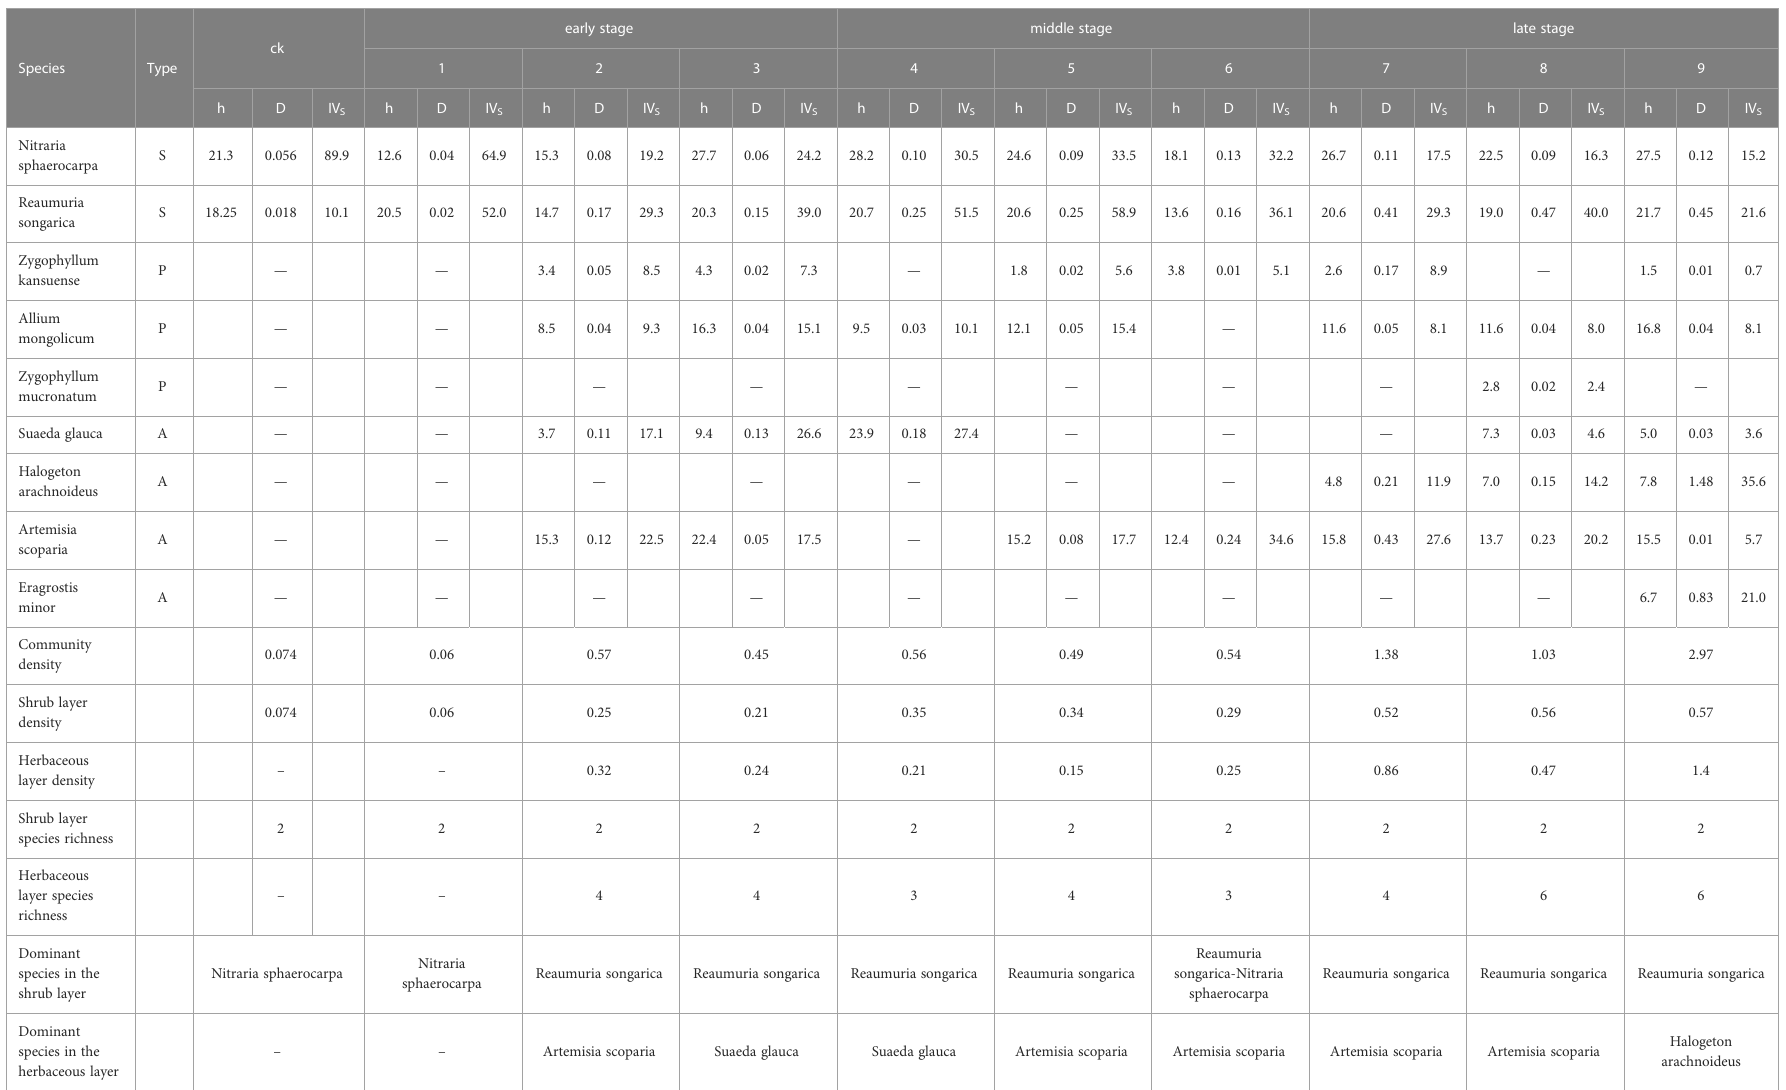
TABLE 2 Importance value of plant community after different fencing years.